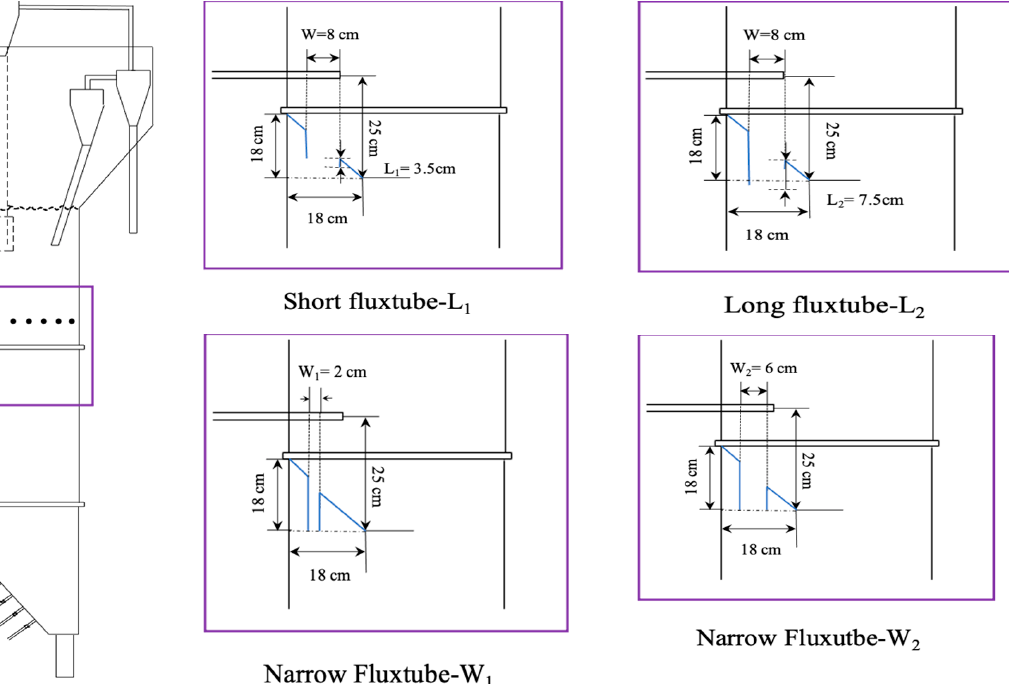
Figure 3. Baffle with fluxtubes of different sizes.